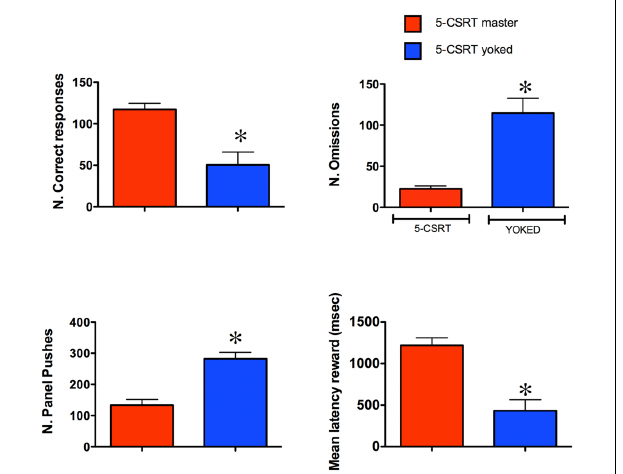
FIGURE 2 |The behavioral performance of master and yoked rats in the 5-CSRT task. The histograms represent mean ± SEM ( n = 7 per group).The stimulus duration and the inter-trial-interval were 0.5 and 5s respectively. * P < 0.05 vs. master; Unpaired Student’s t